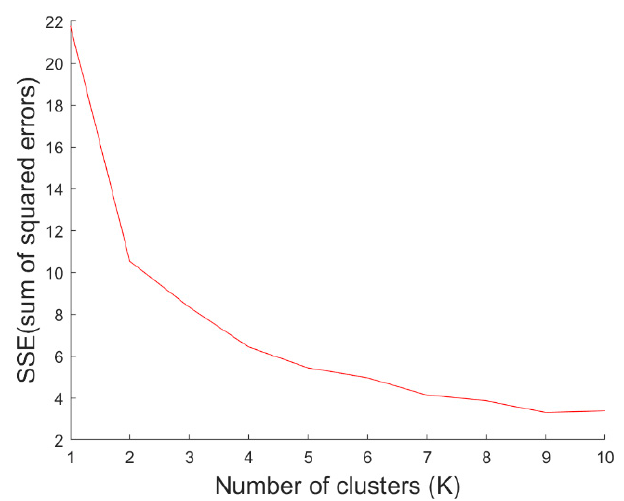
Figure 7. The curve obtained by the elbow algorithm.